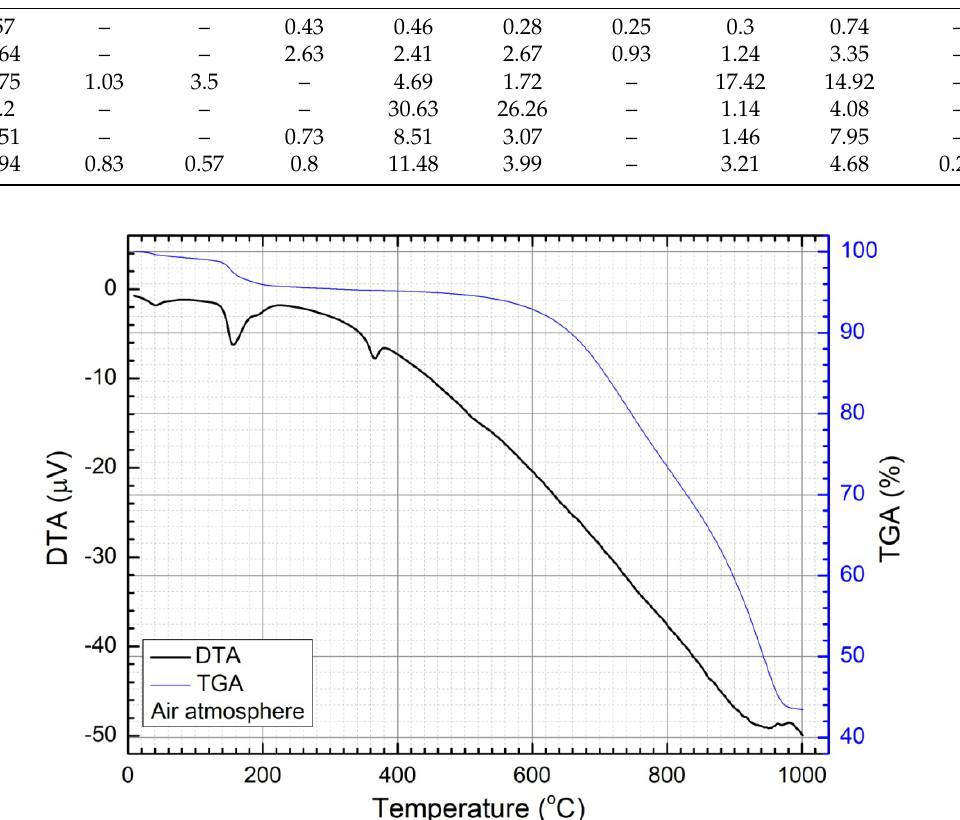
Figure 7. Thermogravimetric analysis (TGA) and differential thermal analysis (DTA) for the